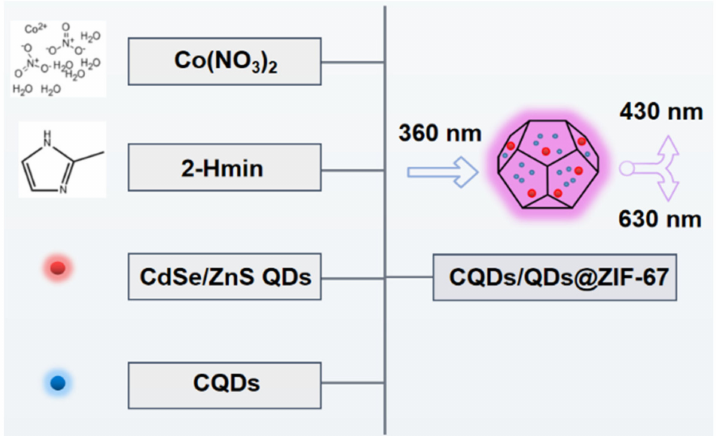
Figure 1. The synthesis process of CQDs/QDs@ZIF-67 at room